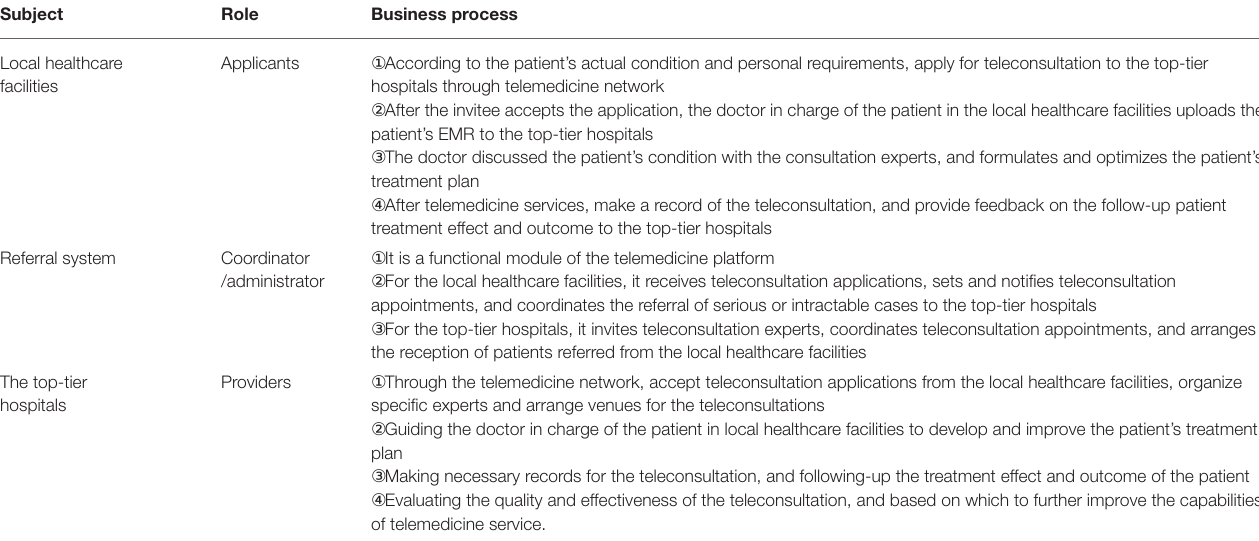
TABLE 3 | The business processes of relevant subjects from different levels during the telemedicine